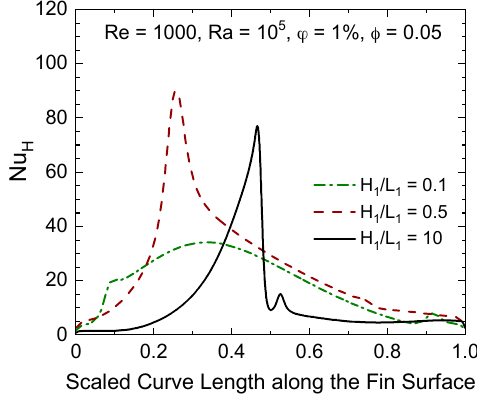
Figure 7. Variations of local Nusselt numbers with fin aspect ratio for the base case parameters (Re = 1000, Ra = 10 5 , ϕ = 1%, and φ = 0.05).